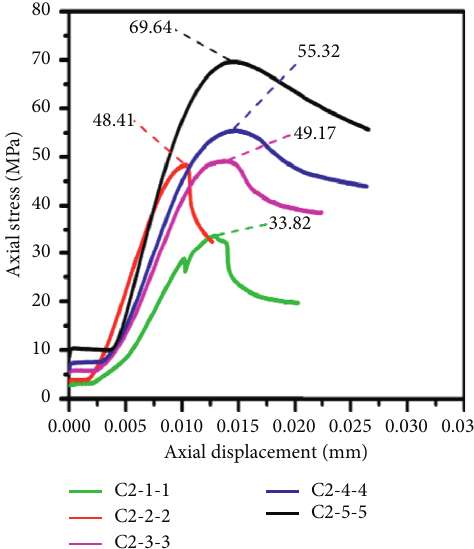
Figure 16: Axial displacement-axial stress curve of group